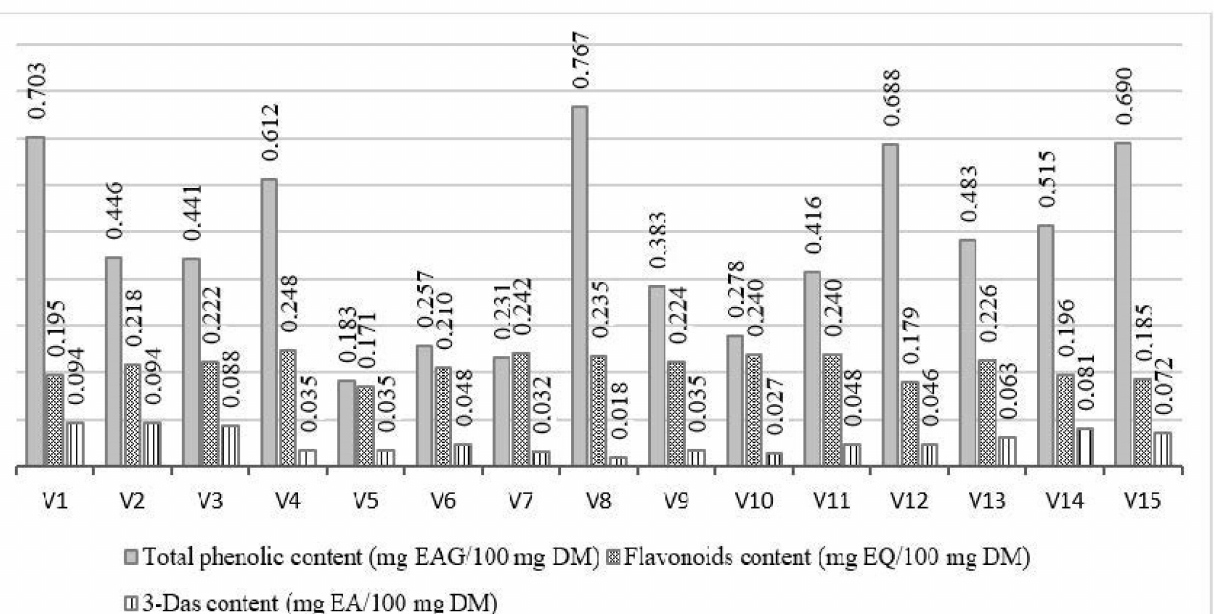
Figure 1. Phenolics content of sorghum